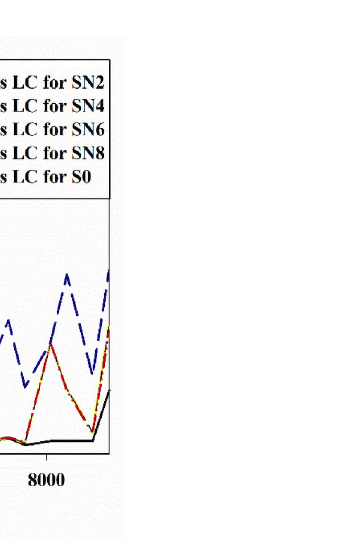
Fig 10. Leakage current aged from 0 hours-9000